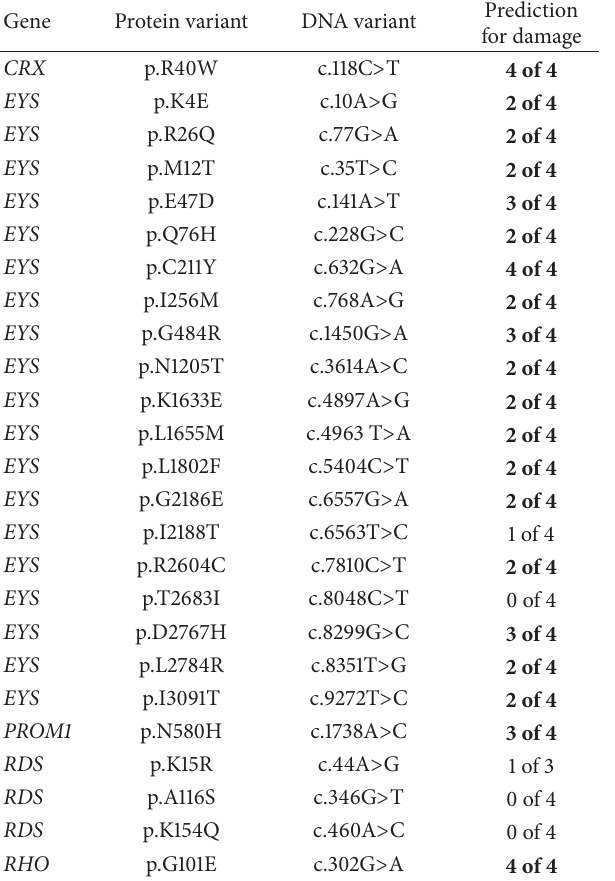
(22 of 82), respectively. No c.4957 4958insA mutation has been detected in 1,208 Japanese individuals without eye symptoms. These data suggest that screening and developing treatment options for these two mutations, c.4957 4958insA and c.8868C > A, can greatly improve RP care in